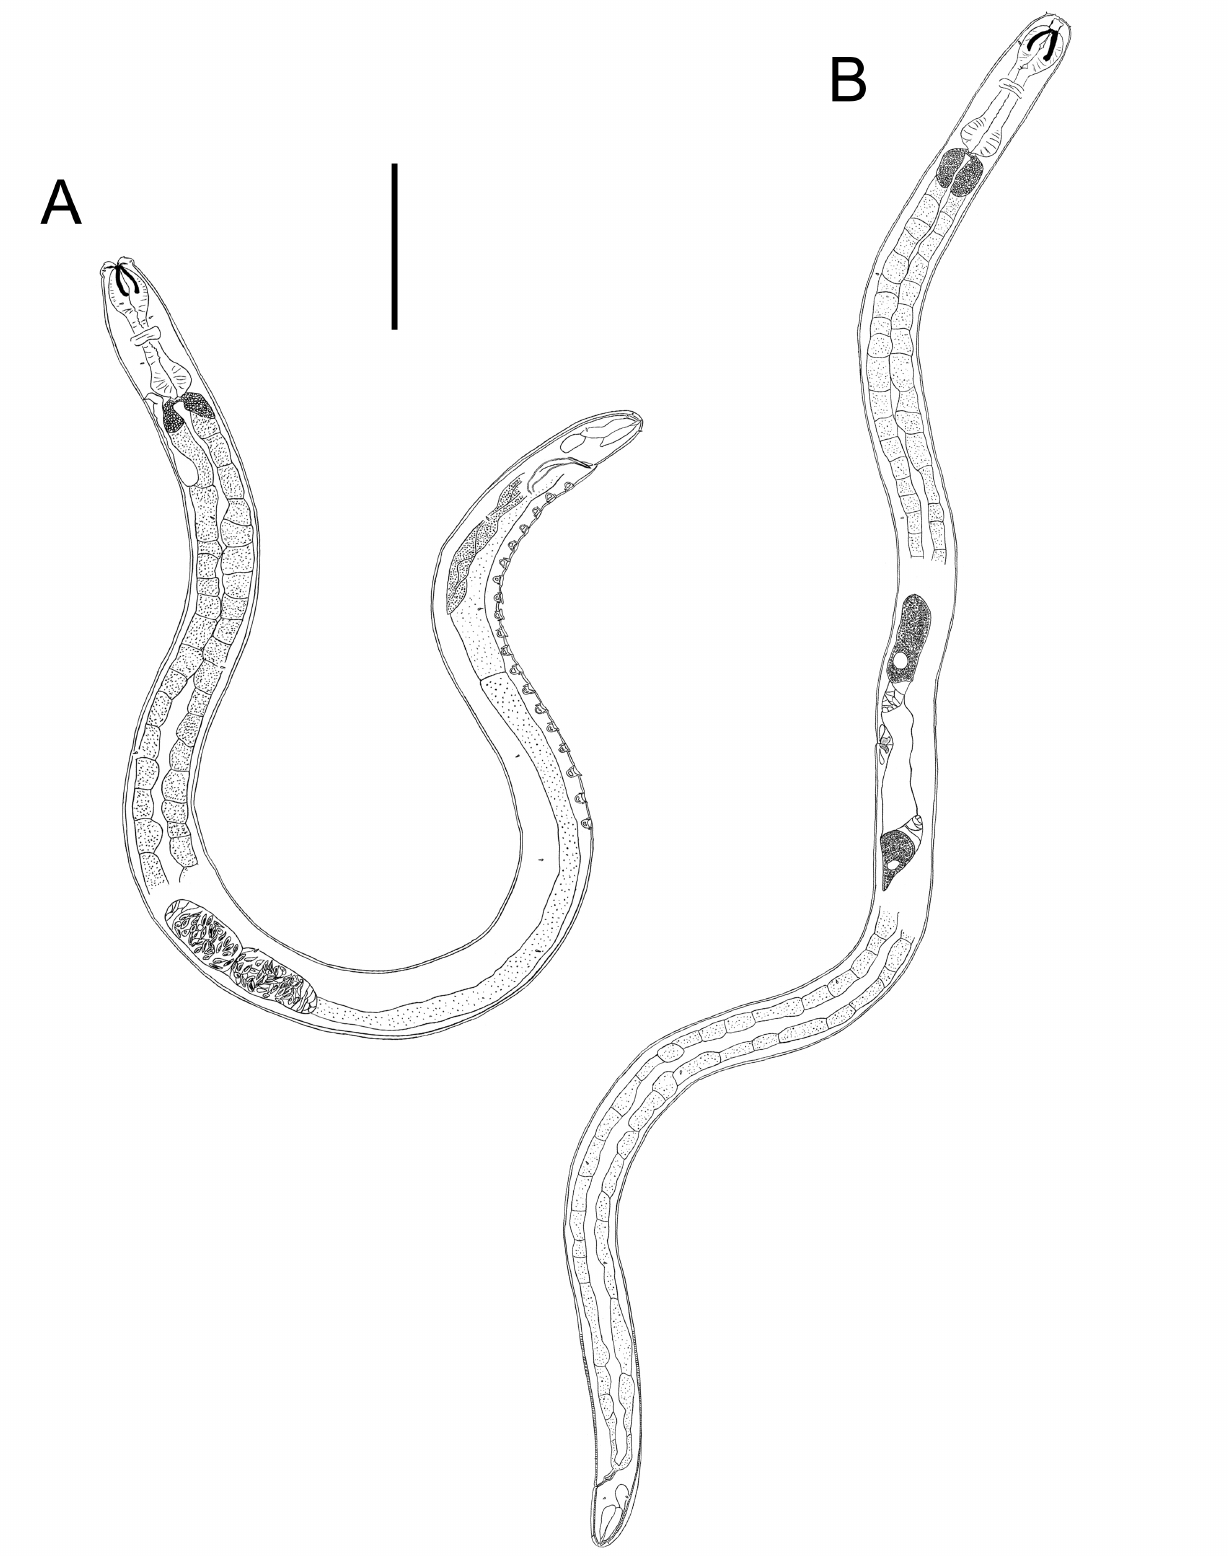
Fig. 6. Pseudocheironchus ingluviosus gen. et sp. nov. A . Entire male. B . Entire female. Scale bar = 100